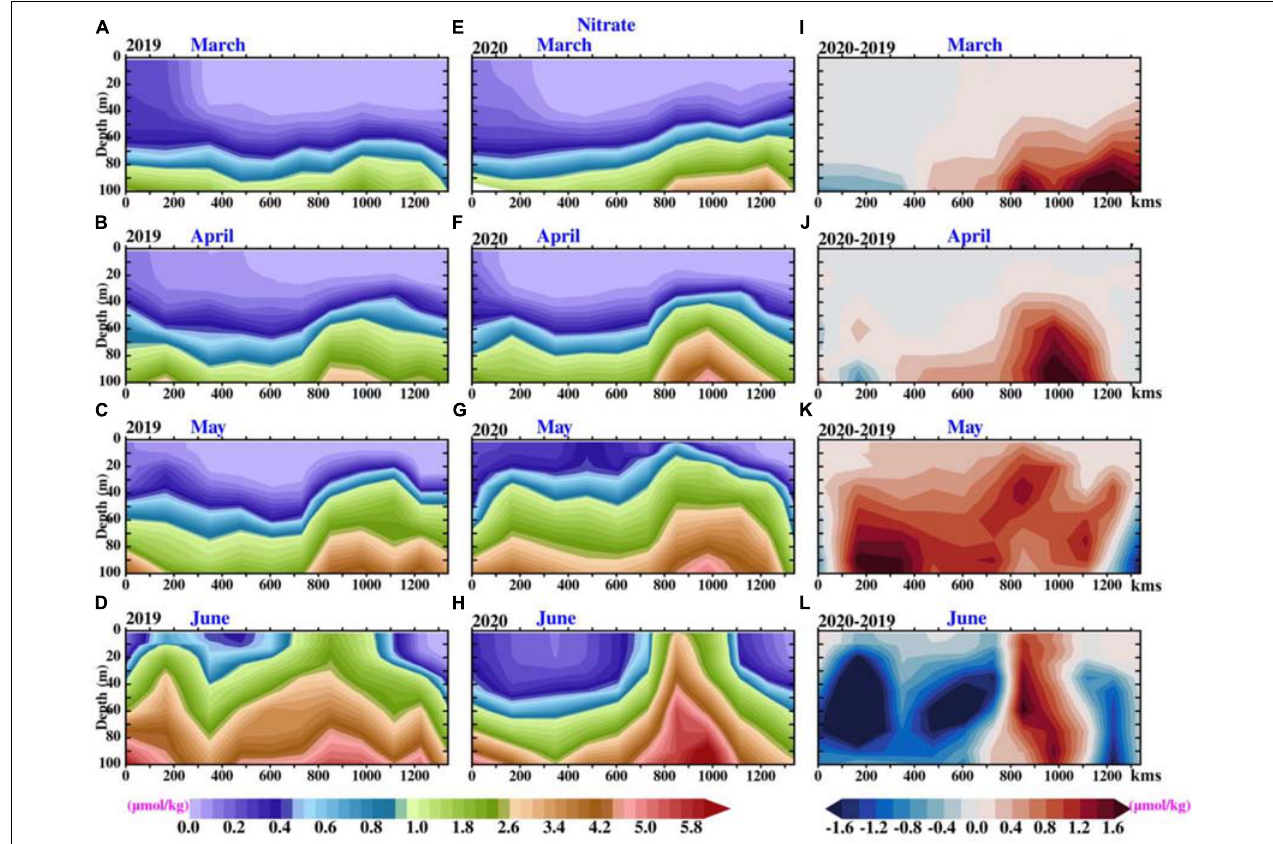
FIGURE 17 | Evolution of model-simulated nitrate along the 1,000 m isobath off Somalia coast (as shown in Figure 1 ), (A–D) during the pre-pandemic period (March–June 2019), (E–H) pandemic period (March–June, 2020), and (I–L) difference in nitrate concentration (2020 – 2019) for respected months from March to